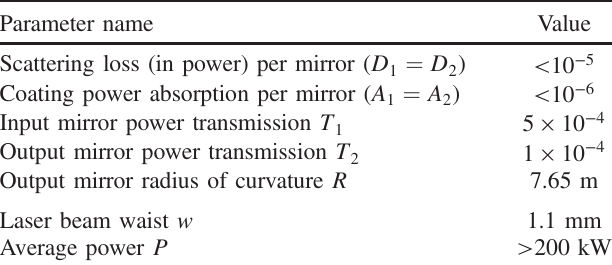
TABLE IV. Summary of optical cavity